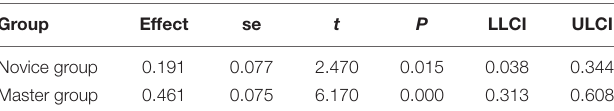
TABLE 11 | Simple slopes analysis.